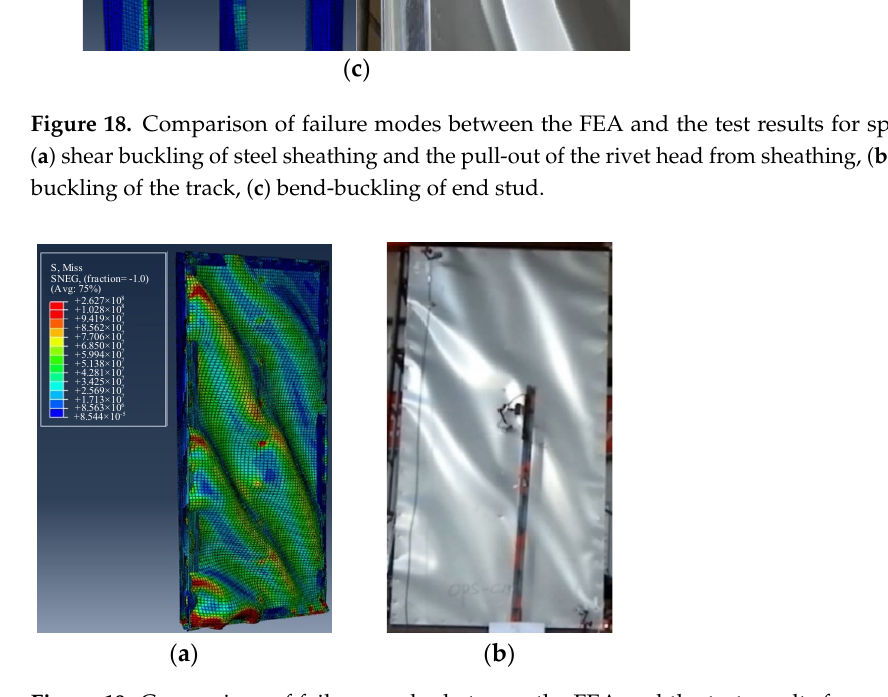
( b ) Figure 20. Comparison of load–displacement curves between the FEA and the test: ( a ) FW-1 (W-1), ( b ) FW-2 (W-2). 5.3.3. Comparison of Eigenvalue A comparison of eigenvalues between the FEA and the test results is presented in Table 10. For the W-1 specimen, the yield displacement, yield load, and maximum dis- placement of FEA were 10.64%, 0.33%, and 12.23% less than that of the test results, respec- tively. The shear stiffness and shear capacity of the FEA were 12.2% and 1.39% greater than that of the test results, respectively. For the W-2 specimen, the yield displacement, yield load, and shear capacity of the FEA were 4.42%, 3.04%, and 0.53% higher than that of the test results, respectively. The maximum displacement and shear stiffness of the FEA were 13.94% and 0.53% lower than that of the test results, respectively.